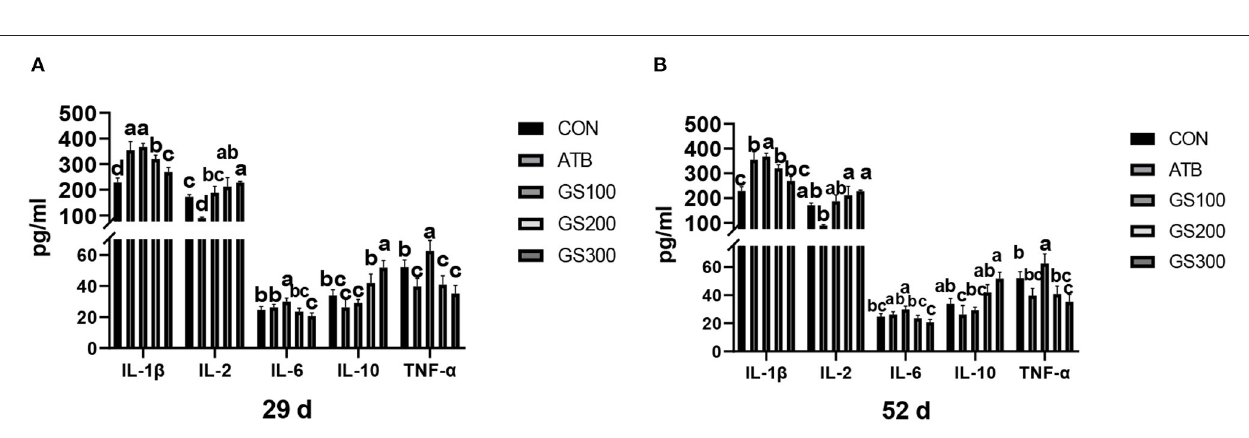
FIGURE 10 | Effects of ginsenoside Rg1 on serum cytokines at day 29 (A) and day 52 (B) in broiler chickens ( n = 6). CON, birds fed a basal diet; GS100, birds fed a basal diet supplemented with 100 mg/kg ginsenoside Rg1; GS200, birds fed a basal diet supplemented with 200 mg/kg ginsenoside Rg1; GS300, birds fed a basal diet supplemented with 300 mg/kg ginsenoside Rg1; ATB, a basal diet supplemented with 300 mg/kg chlortetracycline. Data were shown as means ± standard deviations. Mean value without the common letter on the data bar in each figure indicated that the difference was significant ( P <